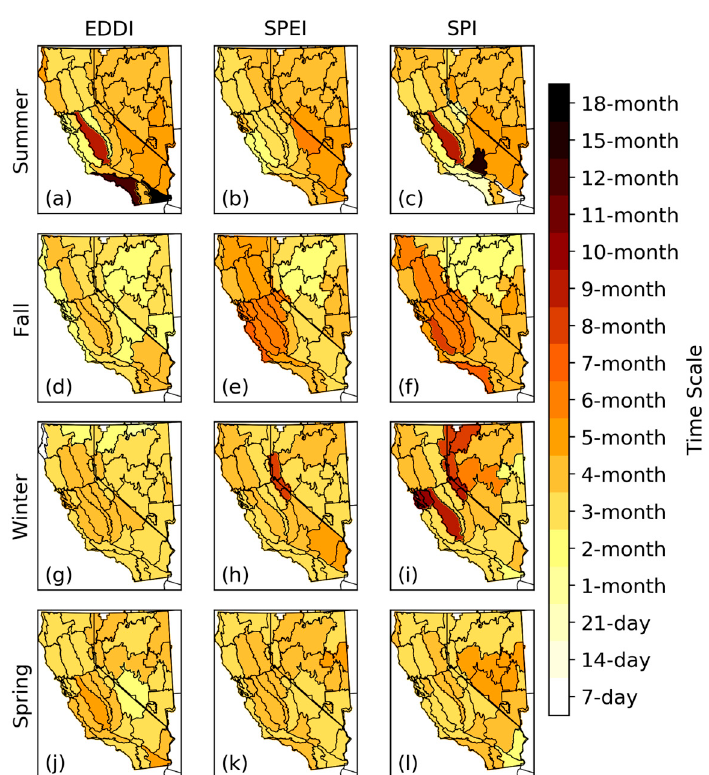
Figure 4. Time scale of each drought index associated with the maximum correlations shown in Figure 2. Drought indices include ( a , d , g , j ) EDDI, ( b , e , h , k ) SPEI, and ( c , f , i , l ) SPI, and seasons include ( a , b , c ) summer, ( d , e , f ) fall, ( g , h , i ) winter, and ( j , k , l ) spring.